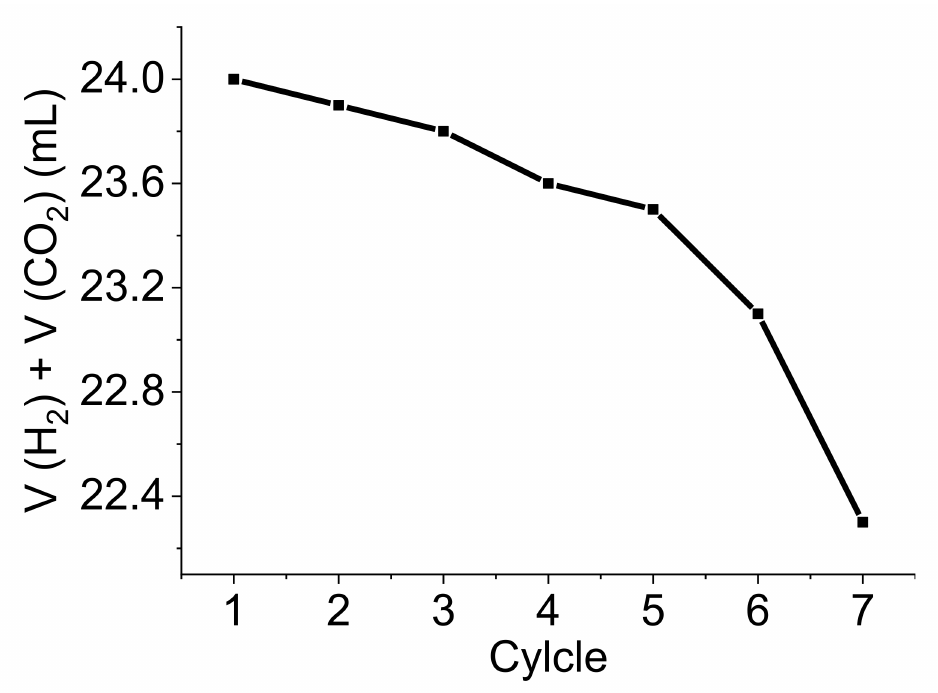
Figure 11. Recyclability test of Pd@C–PS for the FA degradation towards H 2 /CO 2